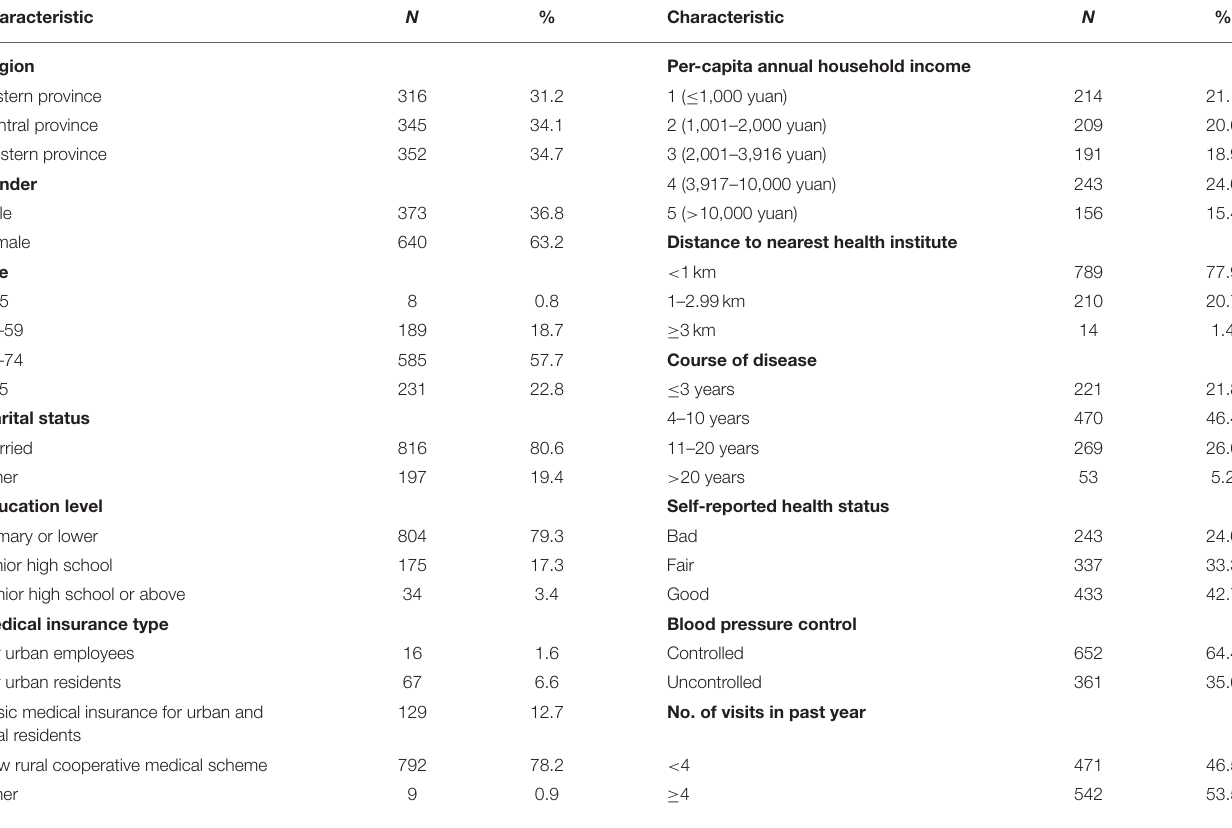
TABLE 3 | Characteristics of the